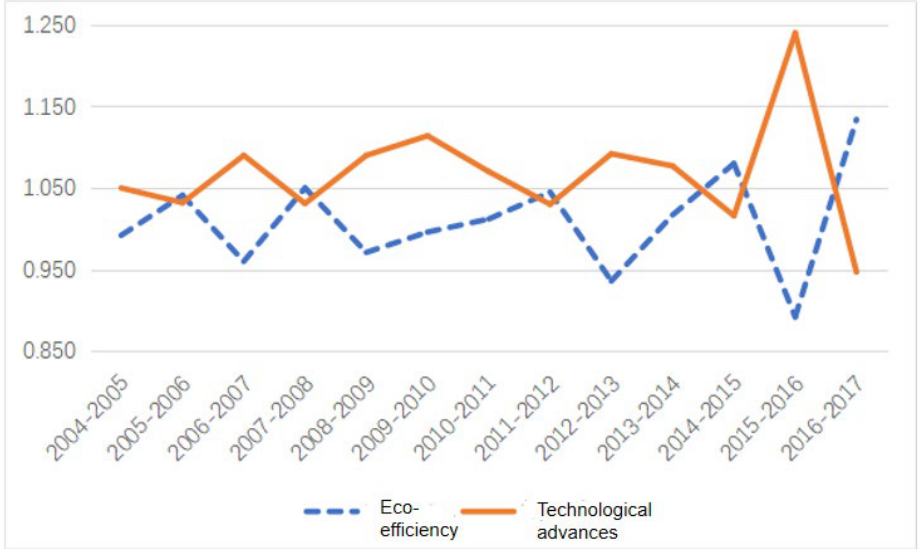
Figure 5. Decomposition of technical efficiency of agricultural land in China.